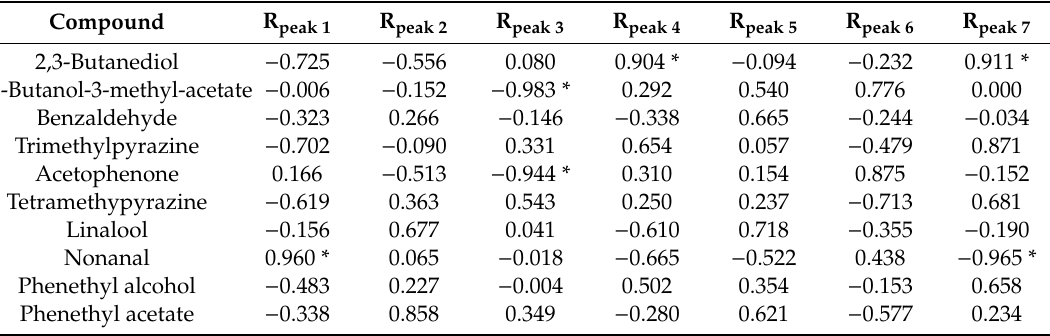
Table 1. Correlation coe ffi cients R between peak areas of selected compounds determined by HS-SPME-GC-MS and peak areas of peaks 1 to 7 from IM fingerprint spectra of bulk cocoa samples ( n = 5).